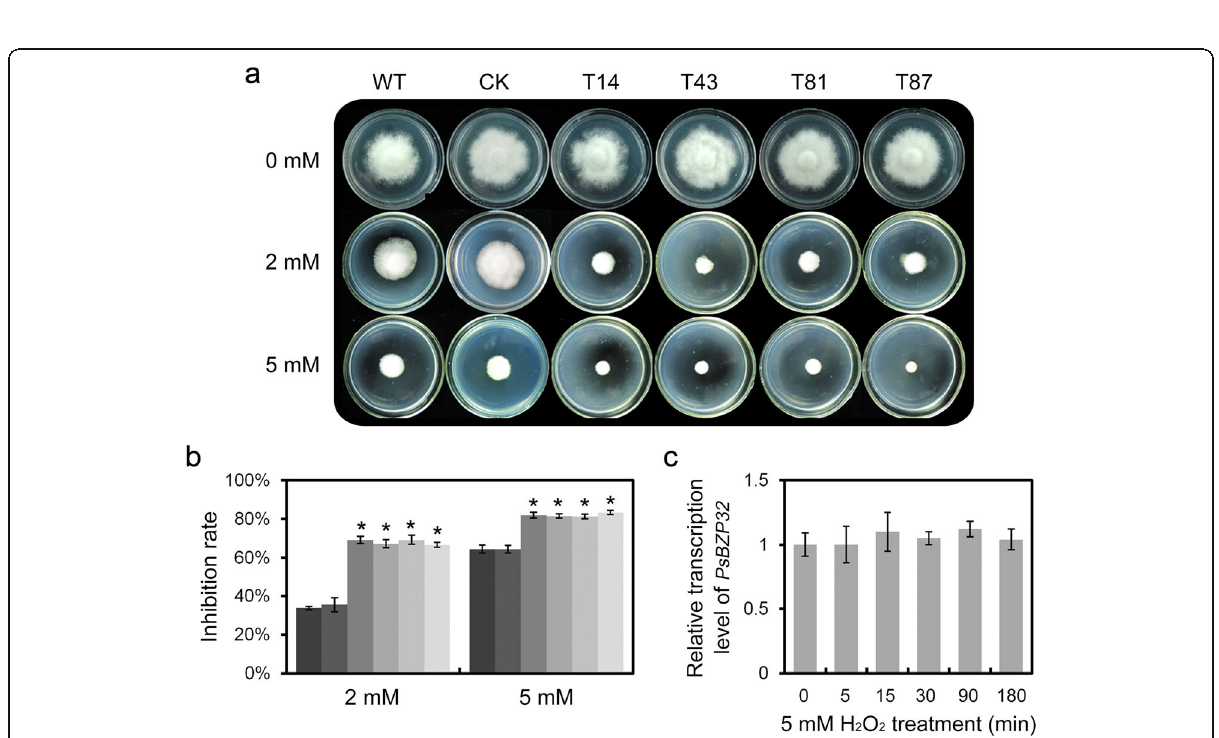
Fig. 4 PsBZP32 -silenced transformants are more sensitive to oxidative stress. a P. sojae strains were inoculated on Plich plates with 0, 2, and 5 mM H 2 O 2 and incubated at 25 °C in the dark for 7 d. b Inhibition rate of mycelial growth after treatment with 2 and 5 mM H 2 O 2 . c Relative transcription level of PsBZP32 at the indicated time points after treatment with H 2 O 2 . *, significant difference compared with the WT (two-tailed t -test, P < 0.01)